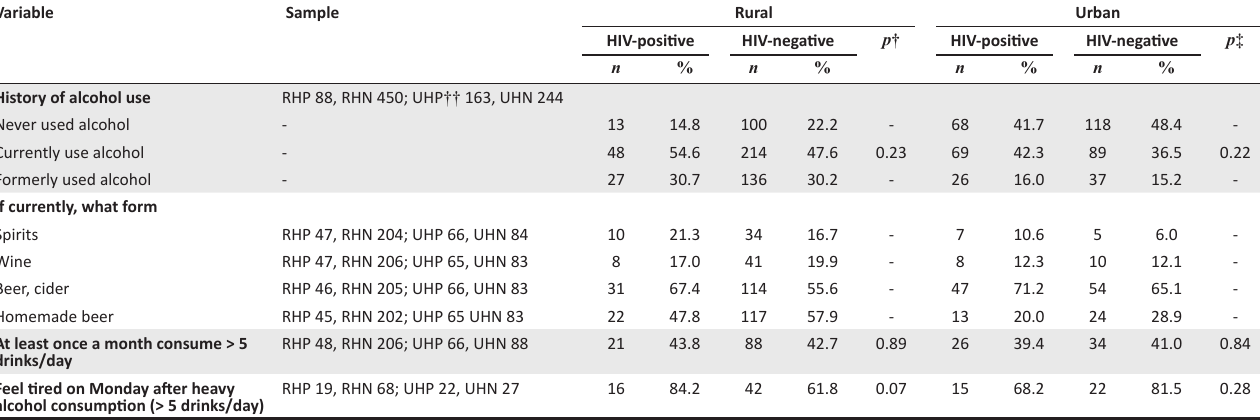
TABLE 2: Alcohol consumption.